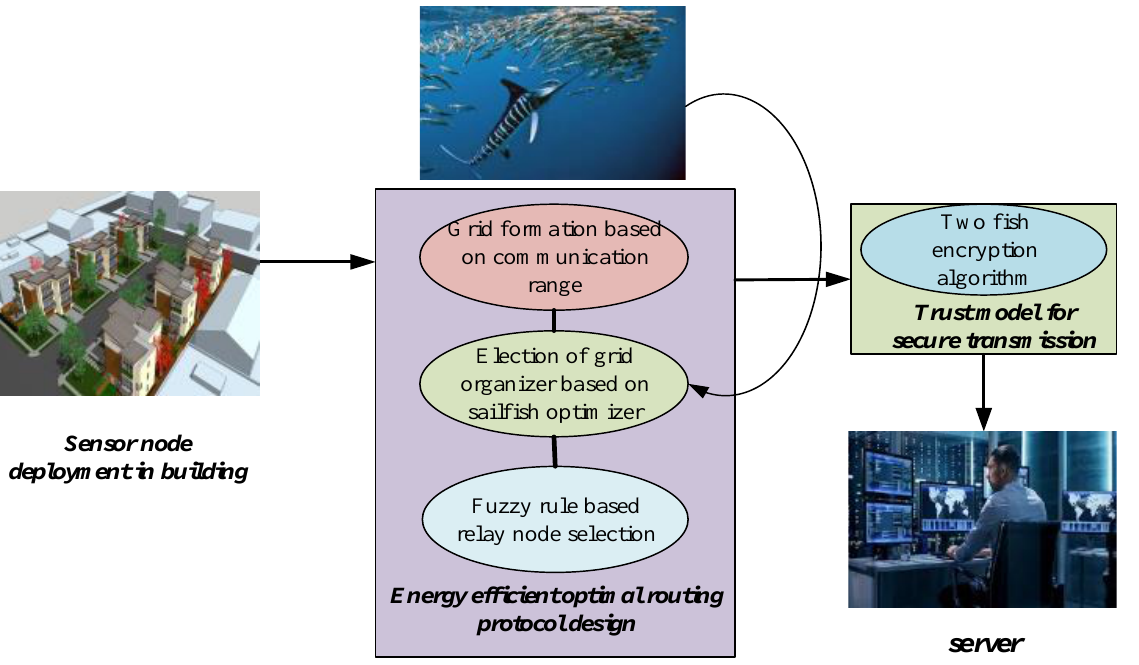
Figure 1. Magnetization as a function of an applied field.